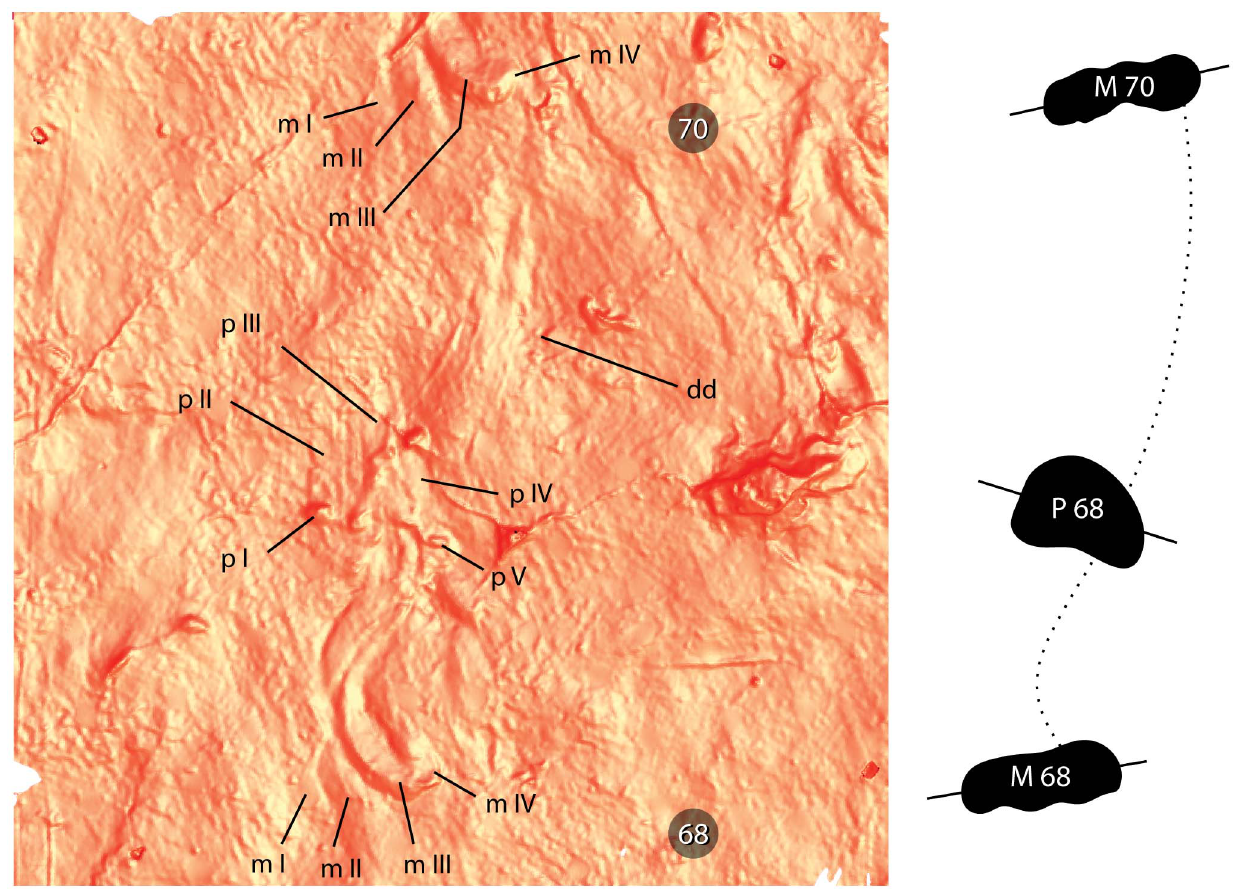
Figure 6. Episcopopusventrosus . Sinusoidal manus drag between successive footfalls. Image at left shows right manus-pes pair 68 and and right manus 70. The rightmost edge of the belly drag, which smoothed the microbially-matted surface, can be seen at left. The interpretive drawing at right shows schematic outlines (filled in black) of the right manus and pes along with a dotted line indicating the arc of curvature of the drag. Abbreviations: I – V , digit numbers; dd , digit drag; m , manus; p , pes.